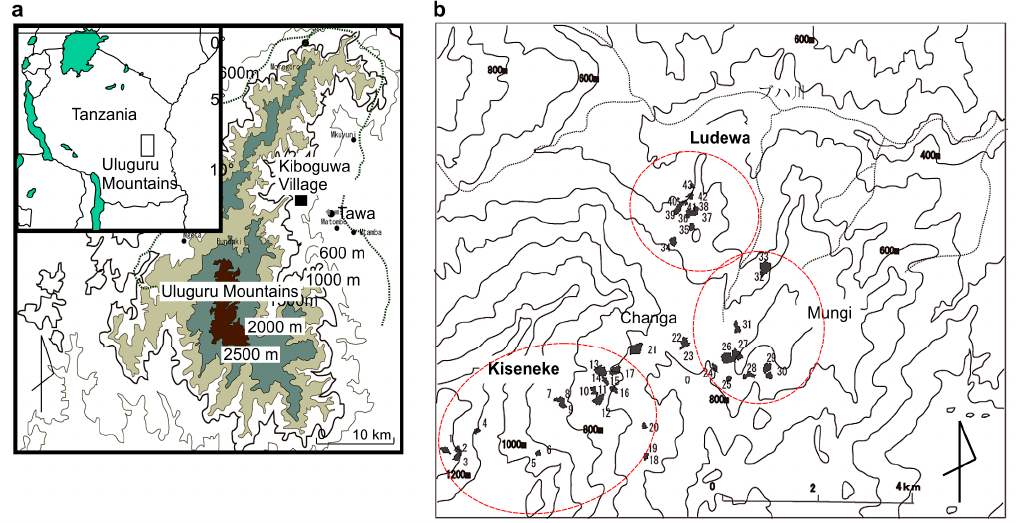
Figure 1. Location of Kiboguwa village in the Uluguru Mountains ( a ); and distribution of the 43 surveyed households in Kiboguwa village ( b ).